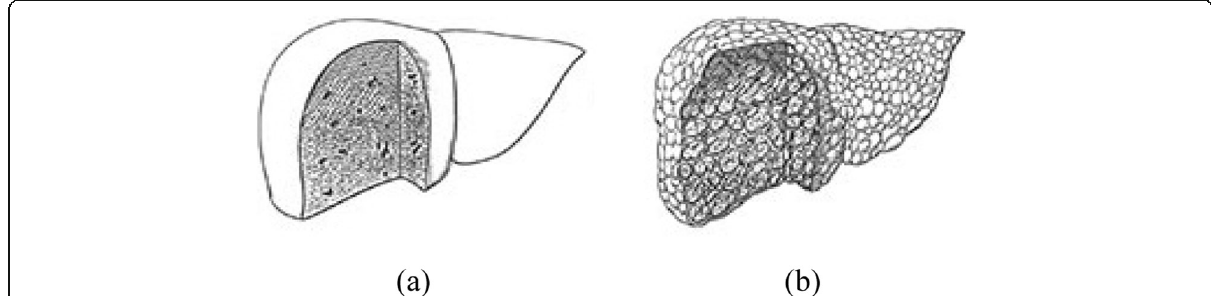
Fig. 1 a Normal liver. b Cirrhotic liver. Given by NIDDKD, National Institutes of Health